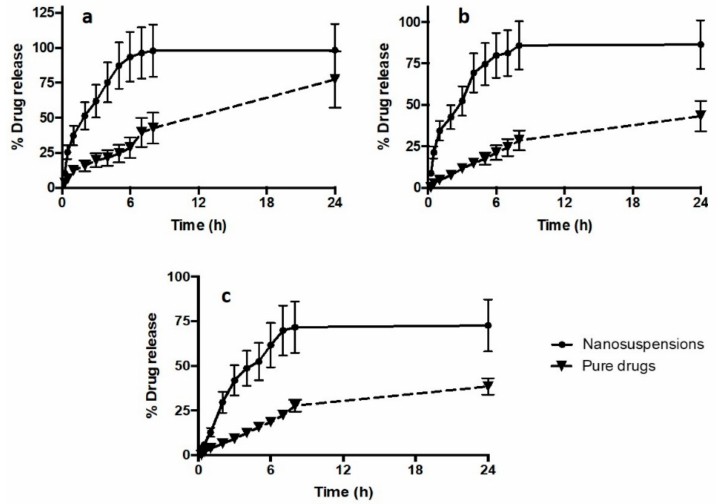
Figure 4. In vitro release profiles of ( a ) DOX NS, ( b ) ABZ-OX NS, and ( c ) IVM NS in comparison with the pure drug (means ± SD, n = 3).